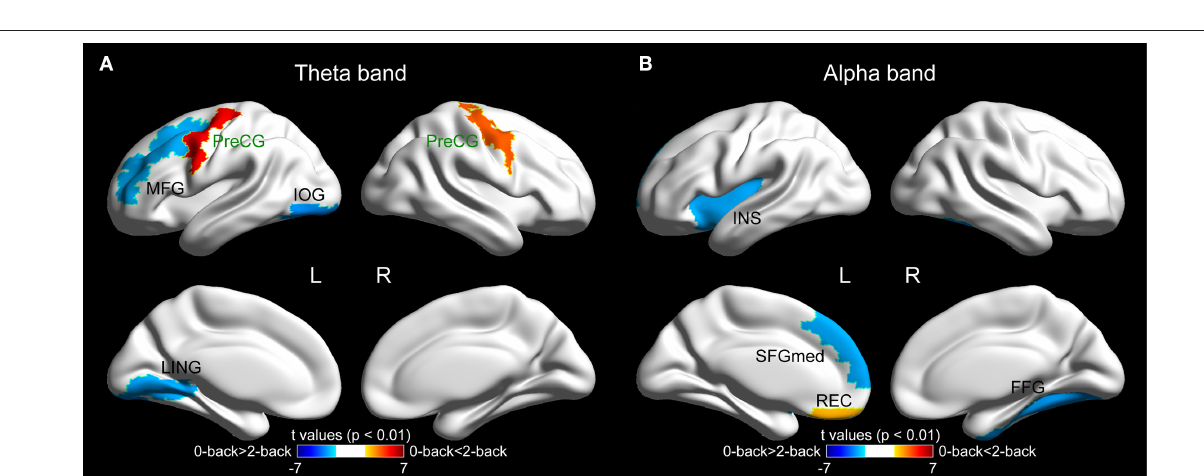
FIGURE 4 | Integrated global metrics (corresponding to the area under the curves of each metric over the entire sparsity range) of the cortical functional connectivity networks in the 0-back and 2-back tasks in (A) theta band, (B) alpha band. The metrics are (from left to right) clustering coefficient ( C ), characteristic path length ( L ), normalized clustering coefficient ( γ ), normalized characteristic path length ( λ ), small-worldness ( σ ), local efficiency ( E local ), and global efficiency ( E global ). The bars represent mean ± standard error. The t - and p -values of the corresponding metrics showing statistically significant differences ( p < 0.05) between the 0-back and 2-back tasks are presented.